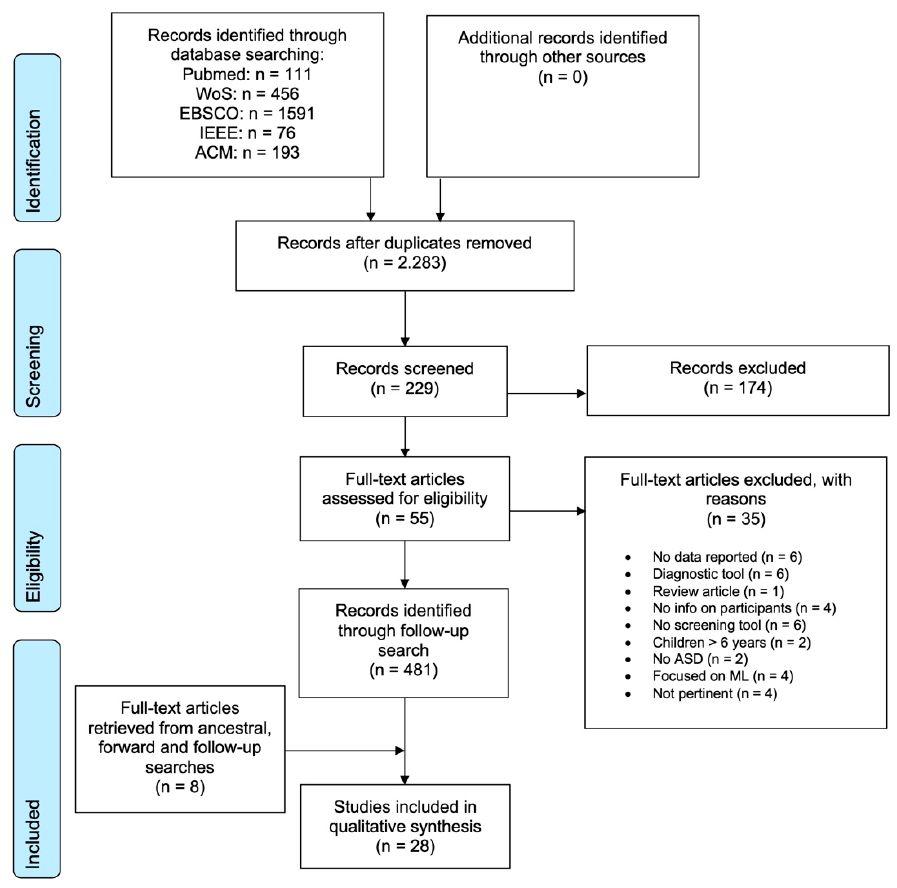
Figure 1. PRISMA flowchart of the articles’ selection process.